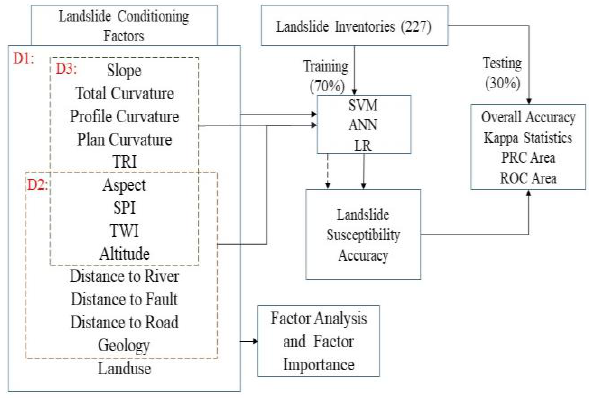
Figure 2. Flowchart of this